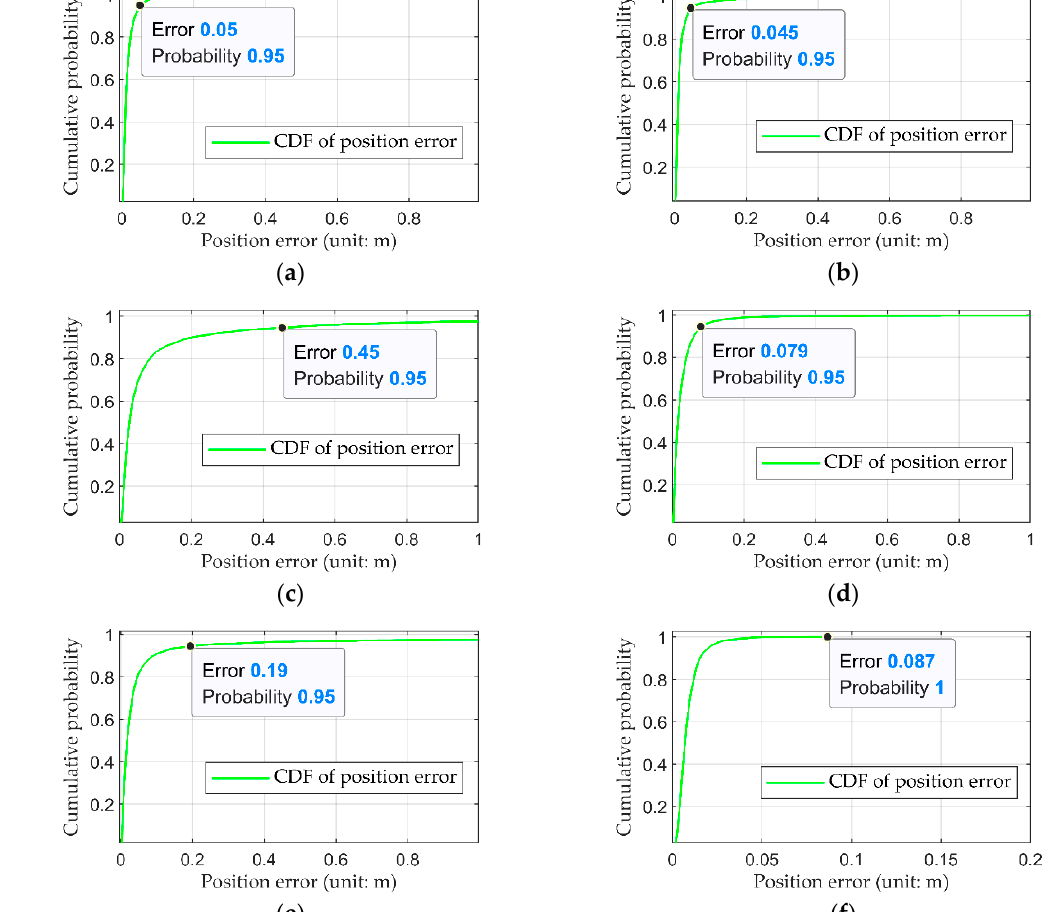
Figure 10. Cumulative distribution function (CDF) of position error in the ( a ) freibuig1_plant, ( b )